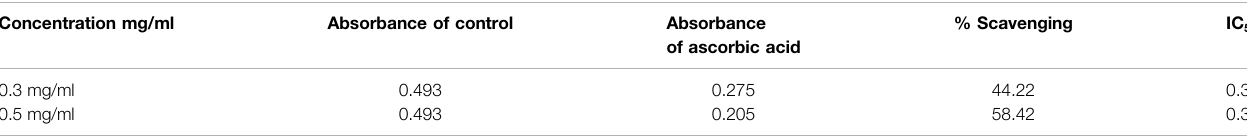
TABLE 5 | Percent scavenging and the standard ’ s IC50 value (ascorbic acid).